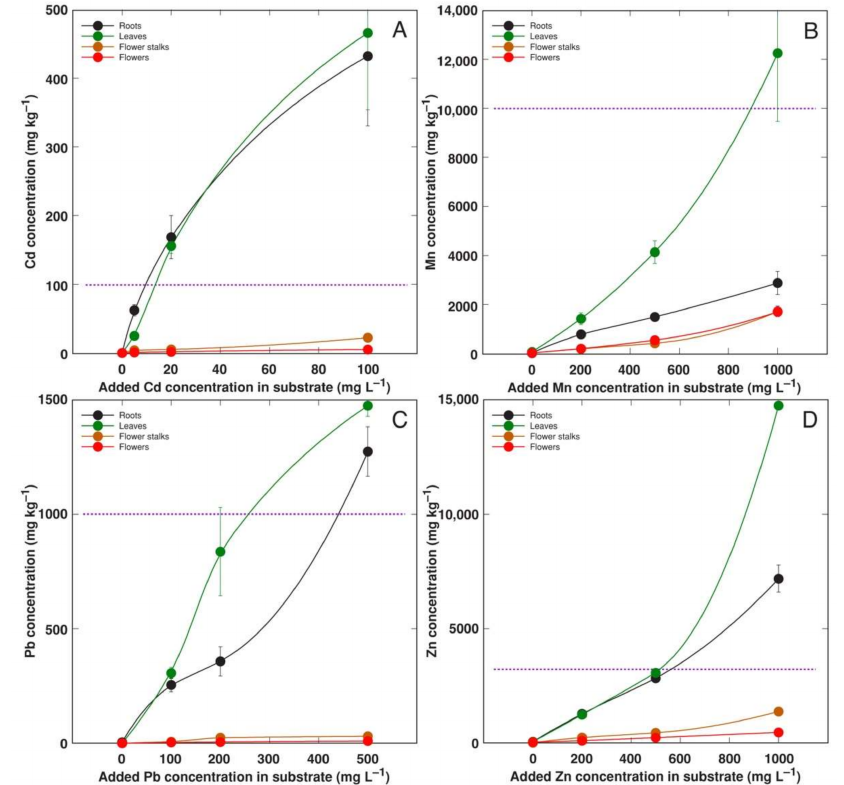
Figure 9. Effect of added Cd concentration in soil on Cd concentration ( A ), added Mn on Mn concen- tration ( B ), added Pb on Pb concentration ( C ), and added Zn on Zn concentration ( D ) in different parts of Armeria maritima plants of accession AM3 after cultrivation for 9 weeks. Data are means ± SE from 3 samples. Dotted line indicates accepted hyperaccumulation threshold level for the respective